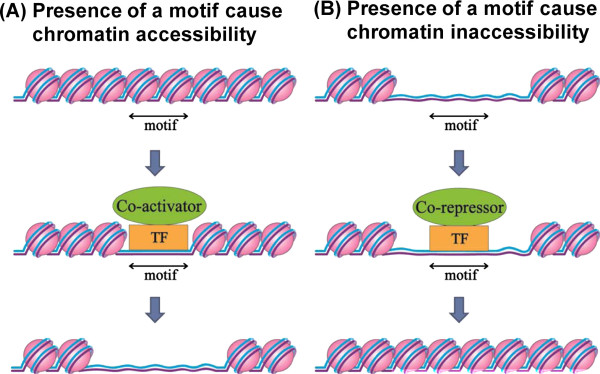
The hypothesis of chromatin motifs. (A) A chromatin motif in the inaccessible state. The TF may bind to the motif with co-activators and then make the chromatin accessible. (B) A chromatin motif in the accessible state. The TF may bind to the motif with co-repressors and then make the chromatin inaccessible.